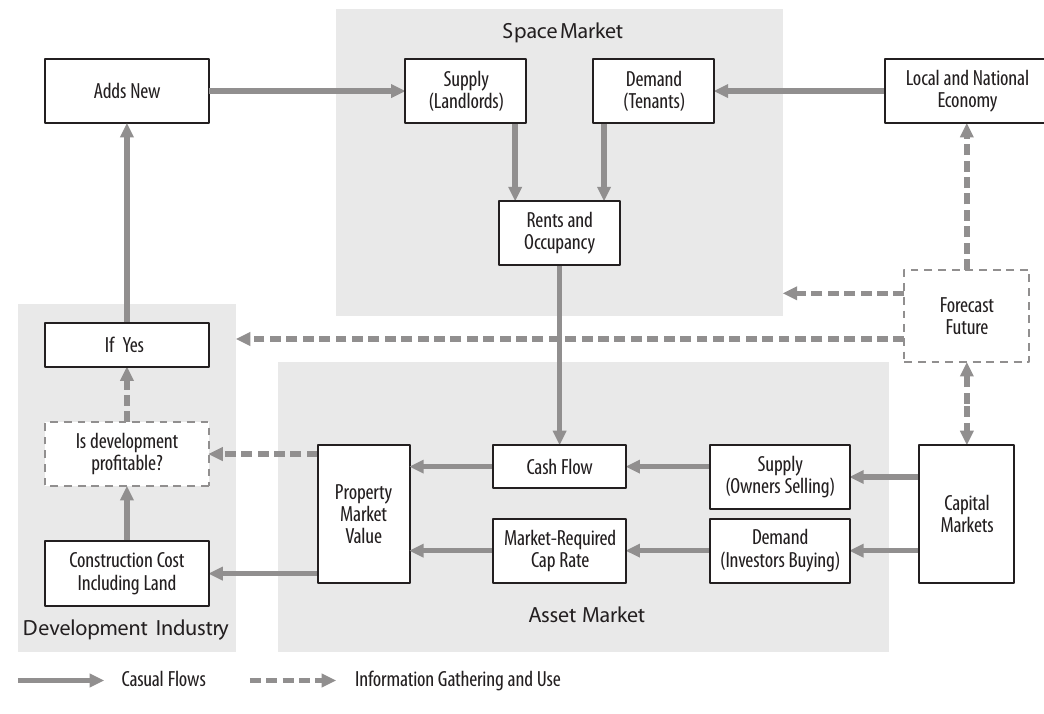
Figure 1. The real estate